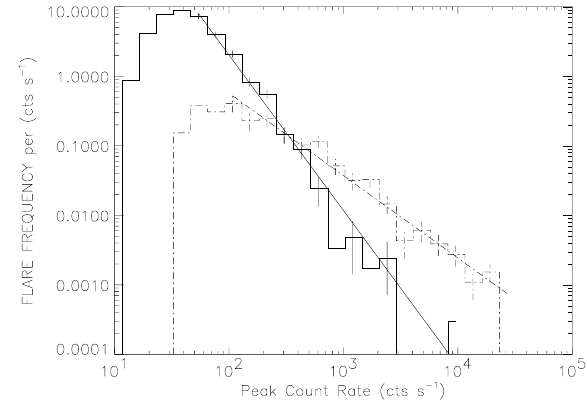
Fig. 1c. Scatter plot between the WATCH total duration with the peak count rate. From Crosby et al. (1998). Table7. Characteristicsofthefrequencydistributionsintotaldurations for subgroups of events (see text for details) (power-law slope α with an exponential roll-over T max ).